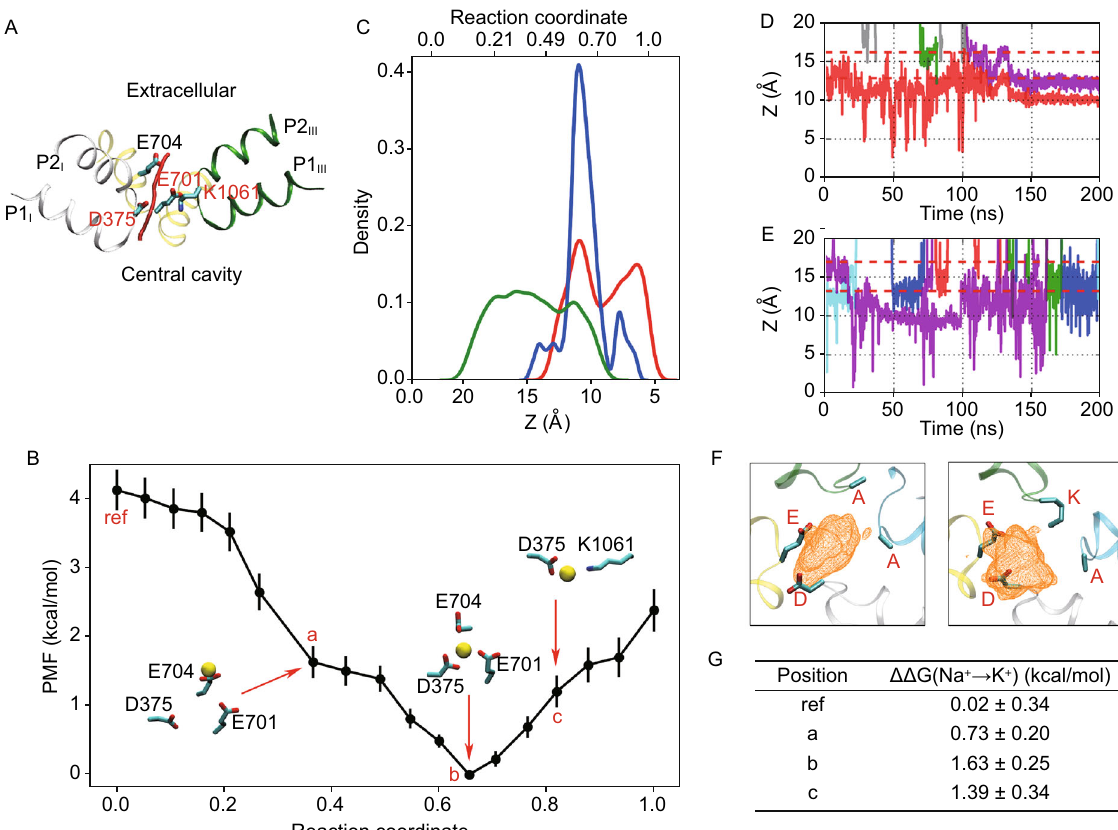
Figure 2. Calculations along the most probable ion permeation path imply the origin of Na + /K + selectivity in Na V Pas . (A) The permeation path (red curve) of Na + ions from the extracellular bulk to the central cavity identi fi ed by the 3D ridge detection algorithm. Only P-loops of homologous repeats I-III are shown for clarity. (B) The PMF pro fi le along the identi fi ed permeation path. Three interesting windows in the umbrella sampling calculations are labeled as a, b and c on the curve, with representative structures shown aside. Representative structures of these three windows as well as a reference window (labeled as ref) were chosen for free energy perturbation calculations. (C) The probability density function of Na + coordination by Glu704 (green), Asp375 (red) and Glu701 (blue) in all windows of the umbrella sampling calculations, respectively. Relationship between window Z-coordinates and reaction coordinates is shown in Fig. S7. (D and E) Time-dependent ion trails of Na + (D) and K + (E) ions in the DEAA derivate. Boundaries of the DEAA region (red dotted lines) were estimated in a similar approach to Fig. S4A and S4B. Trails of ions that have ever entered the DEAA region are displayed in different colors to distinguish the ion identity, while the others are shown in grey. (F) Top views of the probability density maps of Na + ions in the DEAA (left) and DEKA (right) proteins. (G) FEP calculations for evaluating Na + /K + selectivity at four positions de fi ned in